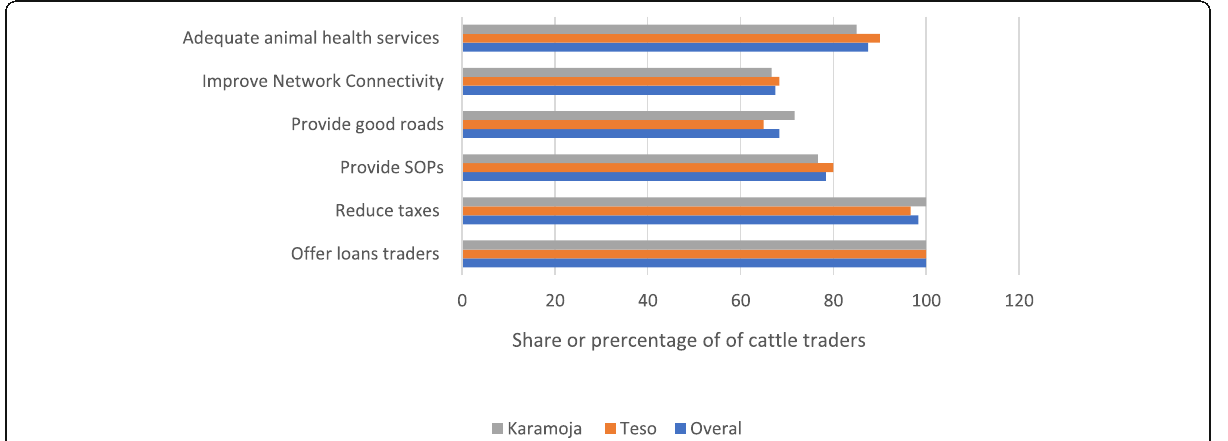
Fig. 11 Percentage of cattle traders reporting the key intervention that government could undertake to support cattle trade in the COVID-19 period. Source: primary